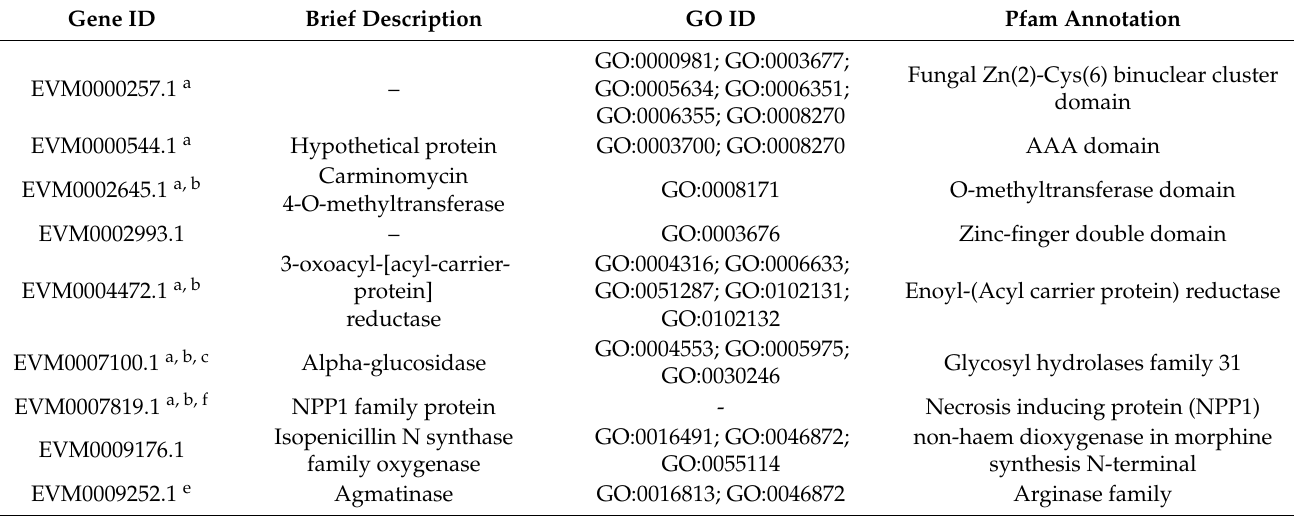
Table 2. Summary of pathogenicity factors potentially related to different lesion